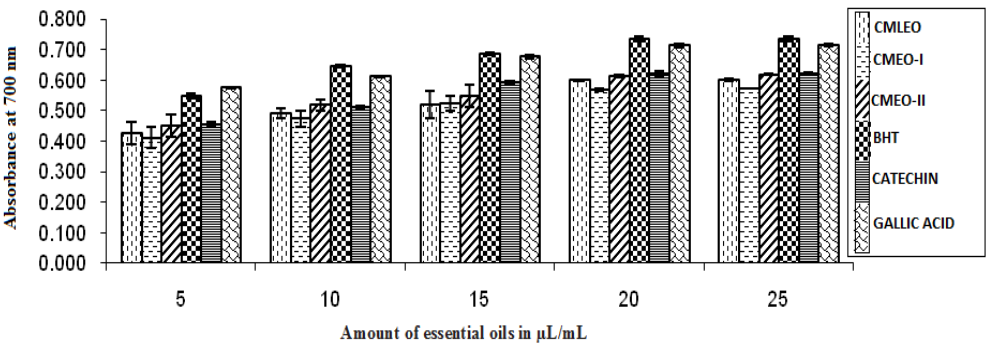
Figure 1. Reducing power activity.